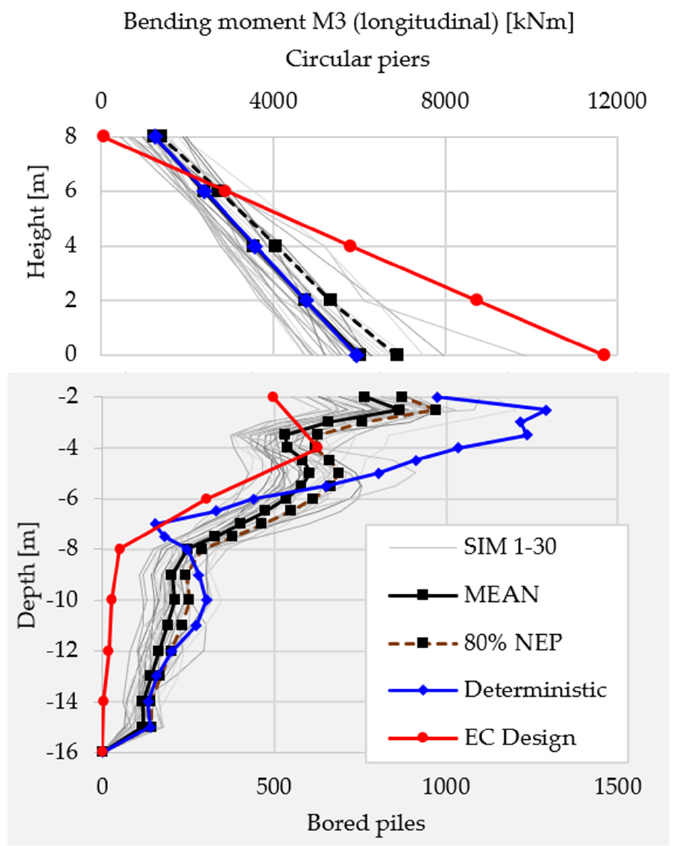
Figure 19. Bending moment M3 (longitudinal) diagram for pier and bored piles.